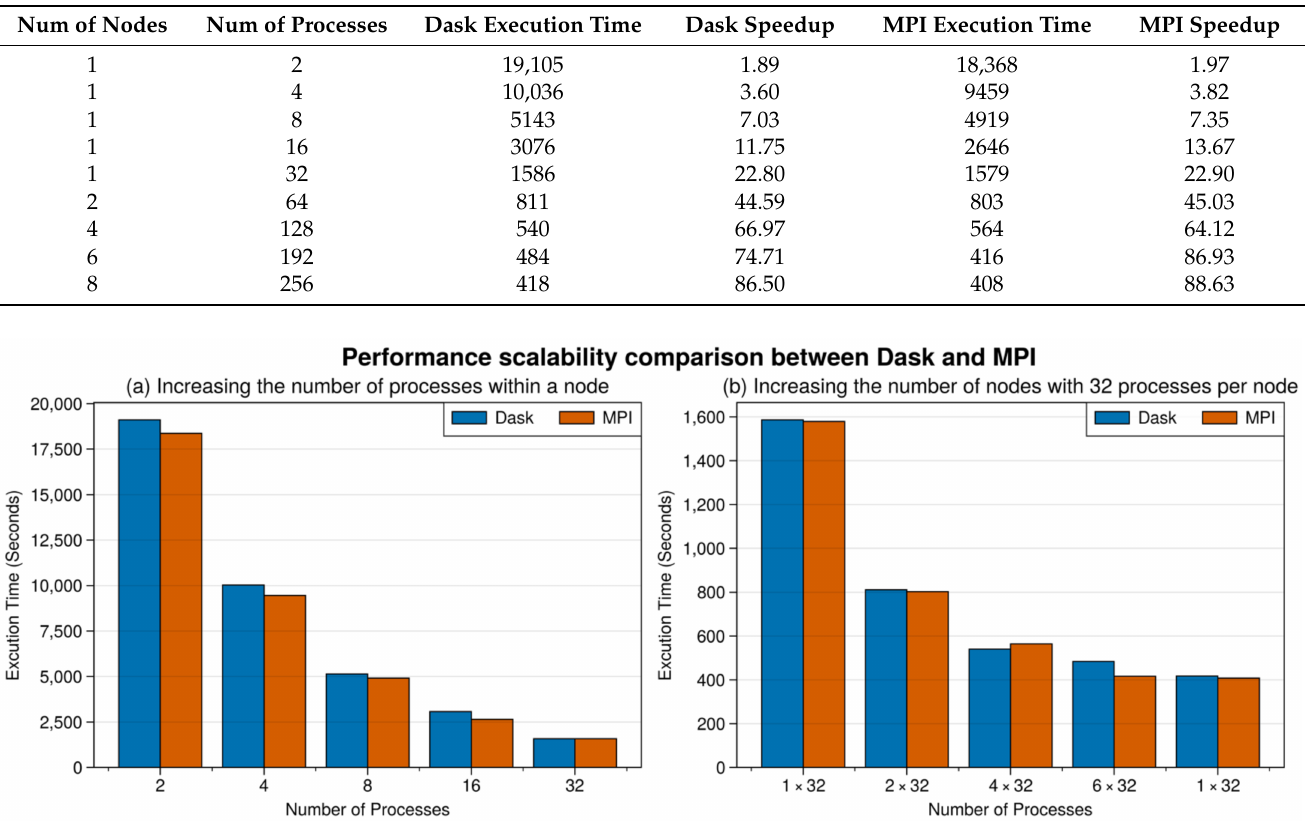
Figure 6. Execution time results (in seconds) for scalability evaluation by ( a ) increasing the number of processes within a node and ( b ) increasing the number of nodes with 32 processes per